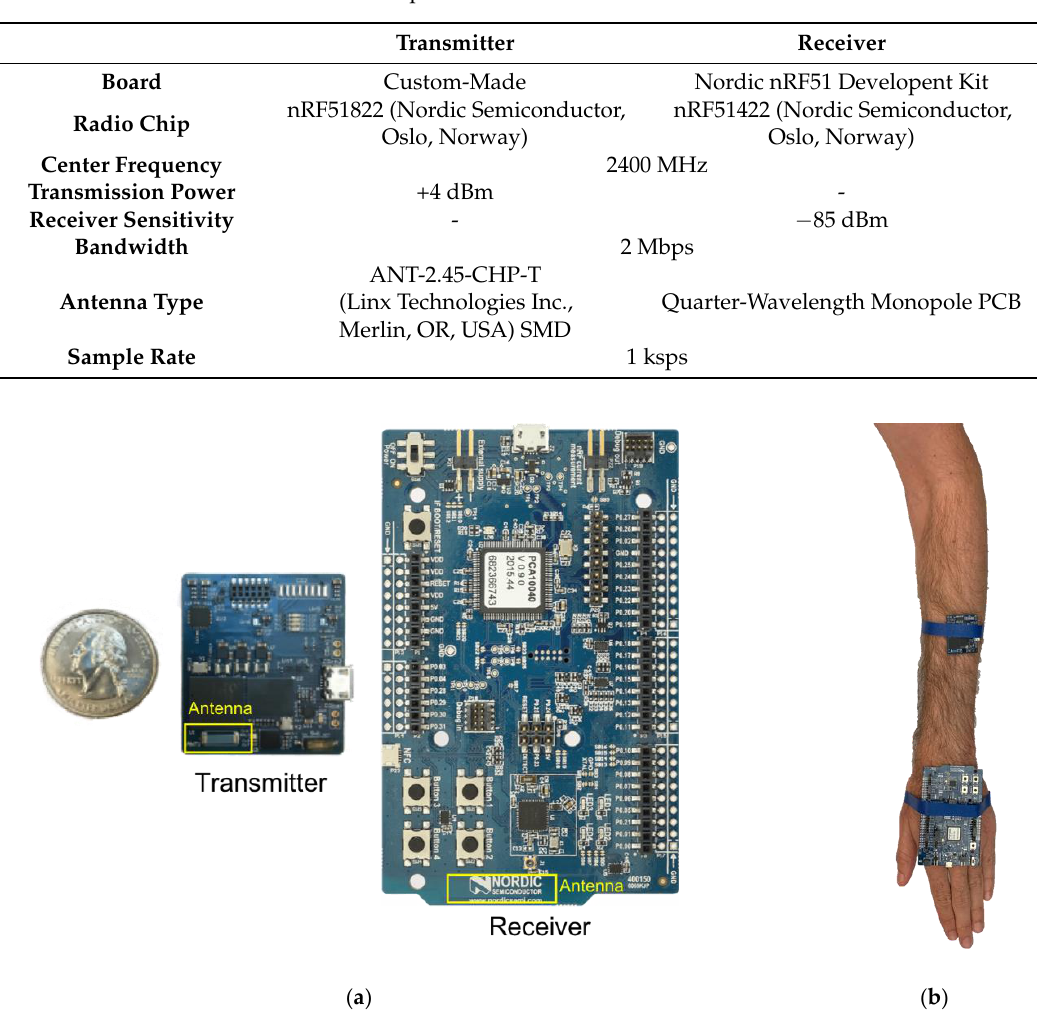
Table 1. Technical Specifications of the used Bluetooth nodes.